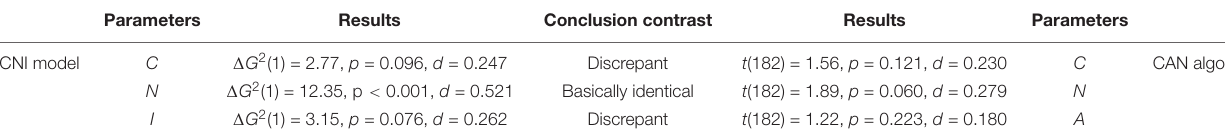
TABLE A5 | Test of psychopathy differences with the CNI model and CAN algorithm in Study 4a by Gawronski et al. (2017). Parameters Results Conclusion contrast Results Parameters